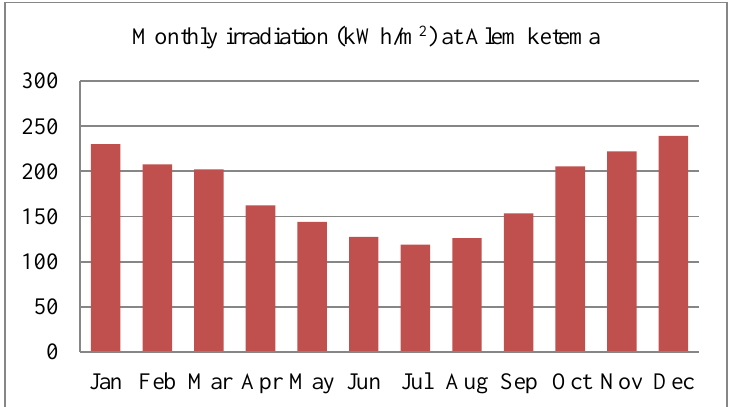
Figure 17. Solar radiation assessment of North Shewa zone at Alem Ketema.